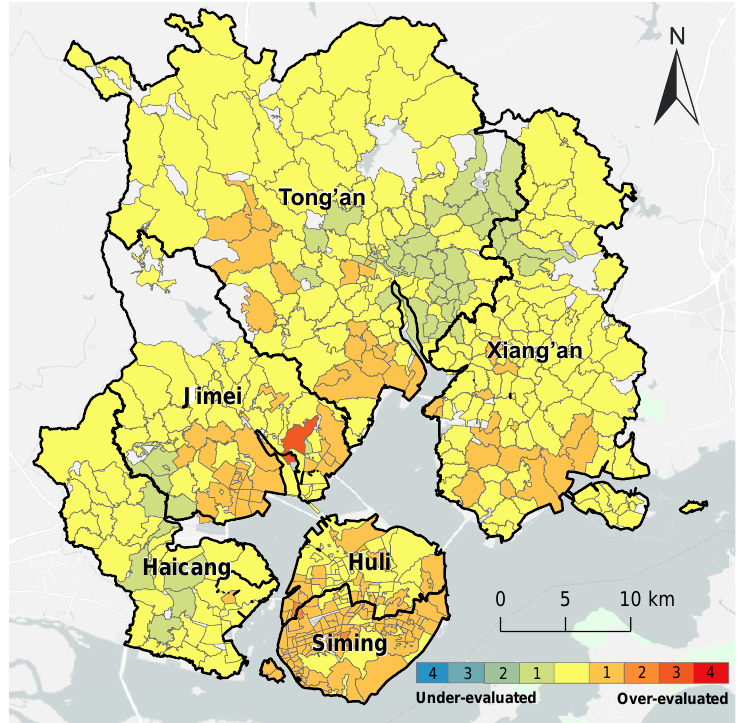
Figure 6. Comparison of the accessibility of internal medicine services with the overall accessibility in Xiamen City.